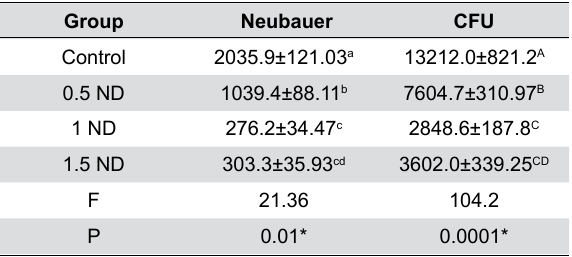
F = ANOVA test, One-way ANOVA and Tukey’s post hoc test (p<0.05) indicate differences among NDs concentrations as shown by superscripts letter; the same letter indicates no significant difference. Table 3- Mean and standard deviations of different studied groups regarding slide count (Neubauer) and Colony forming unit